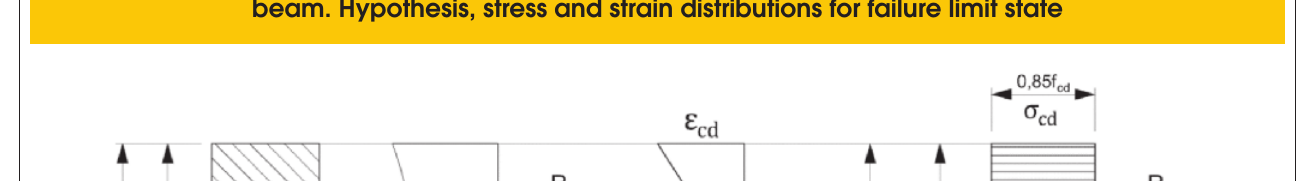
Figure 1 – Rectangular cross-section of a rectangular reinforced